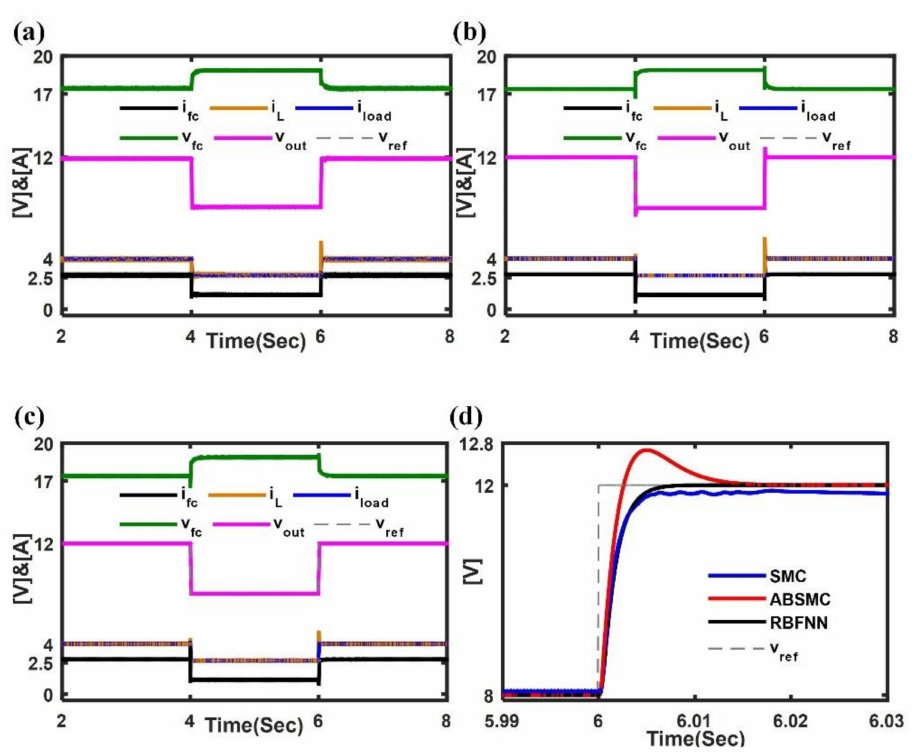
Figure 6. Simulation results in Condition 3: ( a ) by SMC; ( b ) by adaptive backstepping SMC; ( c ) by RBFNN; ( d ) output voltage controlled by different control methods, enlarged view at 6 s.